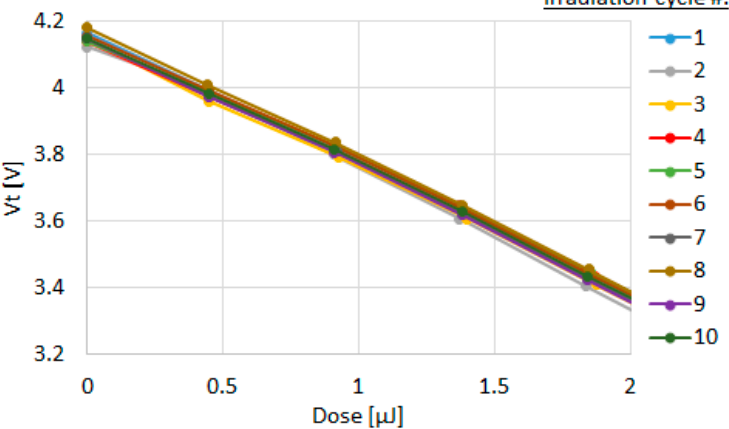
Figure 3. Kinetics of FG discharge after 10 program-discharge cycles. Degradation was not ob-